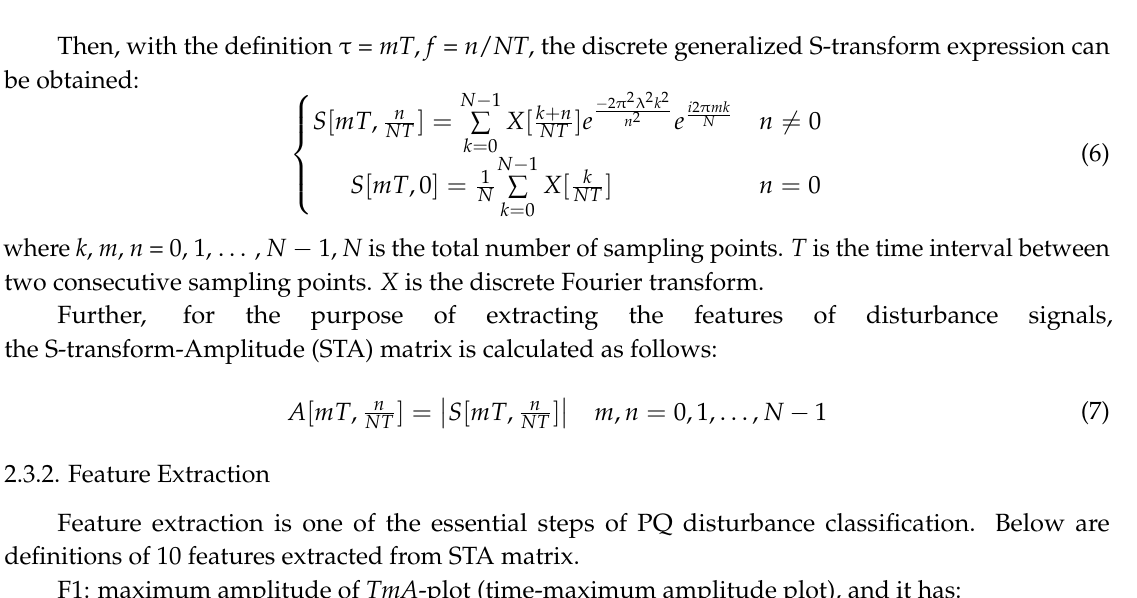
Figure 3. Time-frequency analysis results with different setting value of the width factor. ( a ) The comparison of the Gaussian windows with different width factor; ( b ) Time-frequency spectrum with λ = 2.0 and ( c ) Time-frequency spectrum with λ =